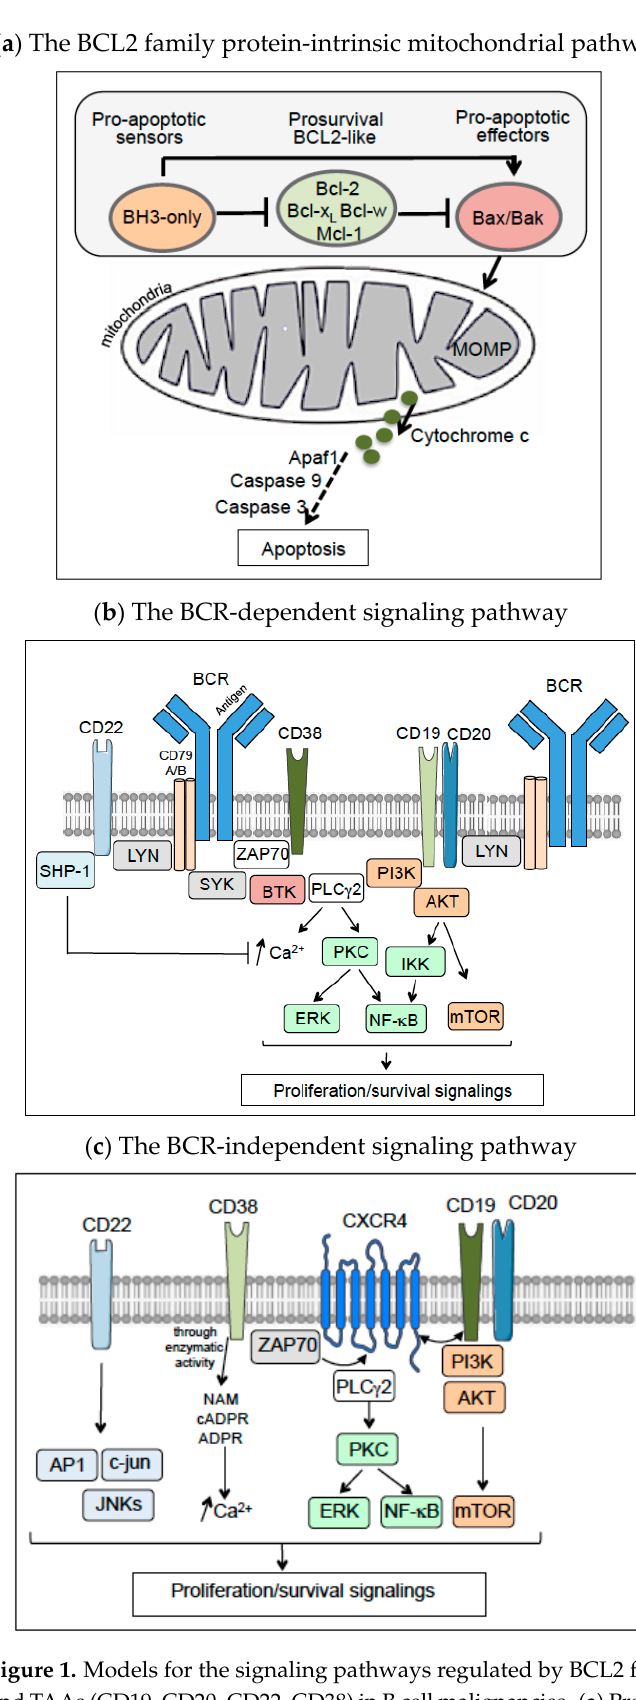
Figure 1. Models for the signaling pathways regulated by BCL2 family proteins, BCR components, and TAAs (CD19, CD20, CD22, CD38) in B cell malignancies. ( a ) Prosurvival BCL2-like proteins (Bcl-2, Bcl-x L , Bcl-w, and Mcl-1) interact with the proapoptotic members called BH3-only proteins (Bim,